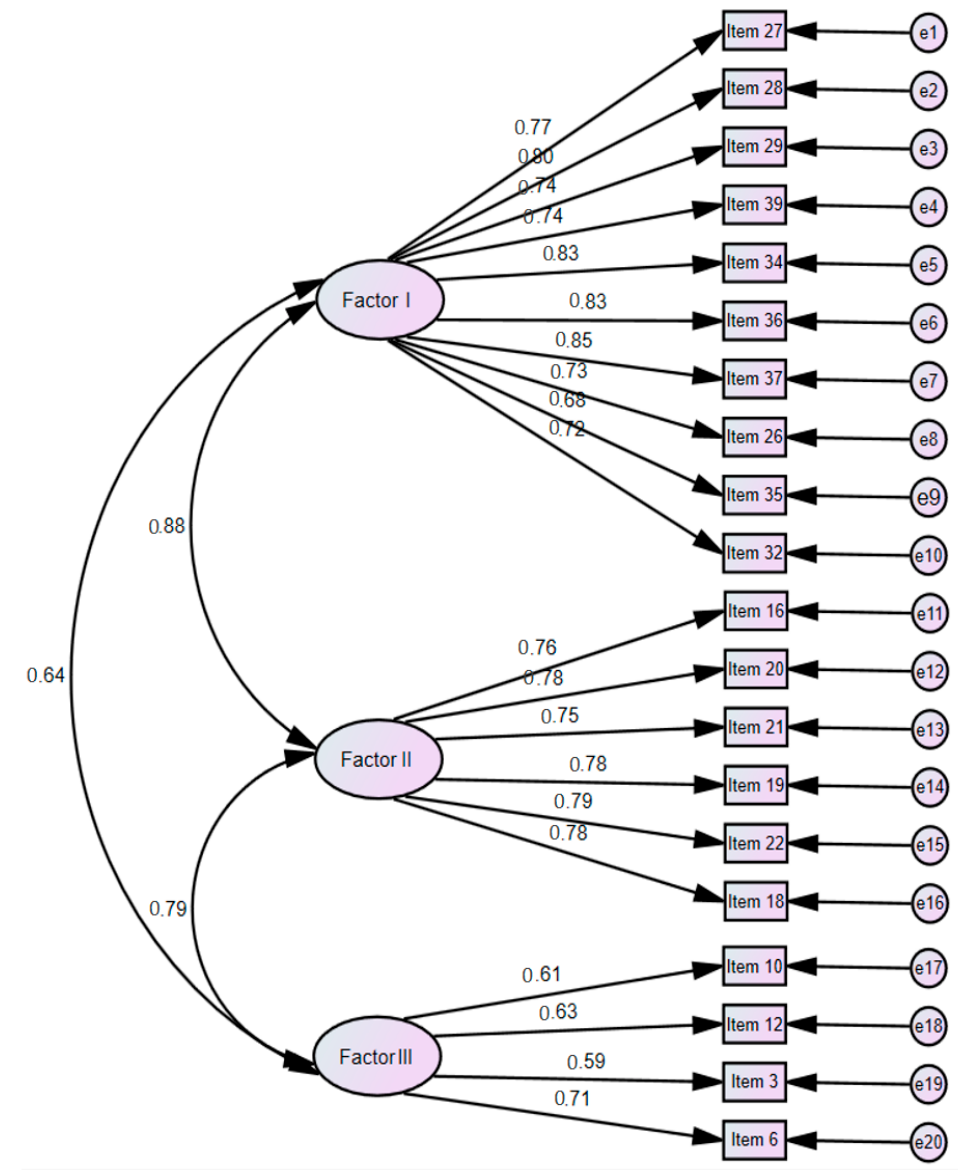
Figure 2. Confirmatory factor analysis of SPIC-F (n = 165) notes. X² ( p ) = 321.72 ( p < 0.001), df = 167, CMIN / df = 1.93, GFI = 0.84, AGFI = 0.80, CFI = 0.93, NFI = 0.86, RMR = 0.02, RMSEA = 0.08. CMIN / DF = chi-square minimum / degree of freedom; GFI = goodness of fit index; AGFI = adjusted goodness of fit index; CFI = comparative fit index; RMR = root mean square residual; RMSEA = root mean square error of approximation.